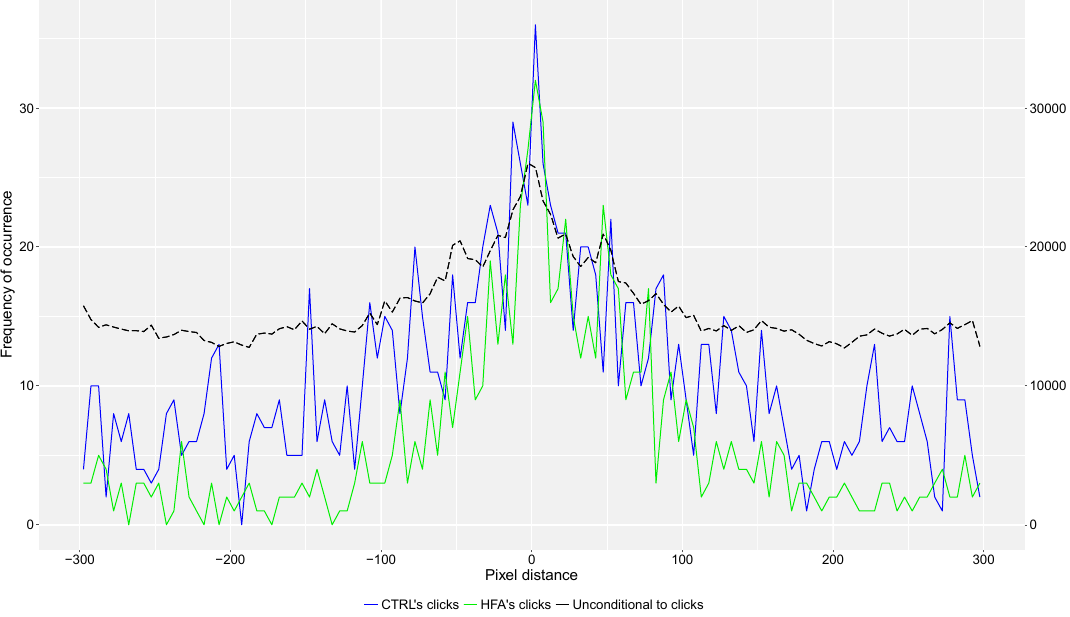
Figure 3. Distances between own and other’s avatar. The frequency distribution of the distances in pixels between the two participants’ avatars is shown. The different colors referred to the overall unconditional to clicks distances, and to those from each group at the time of clicking (4-pixel bins, as objects are 4 pixels wide).